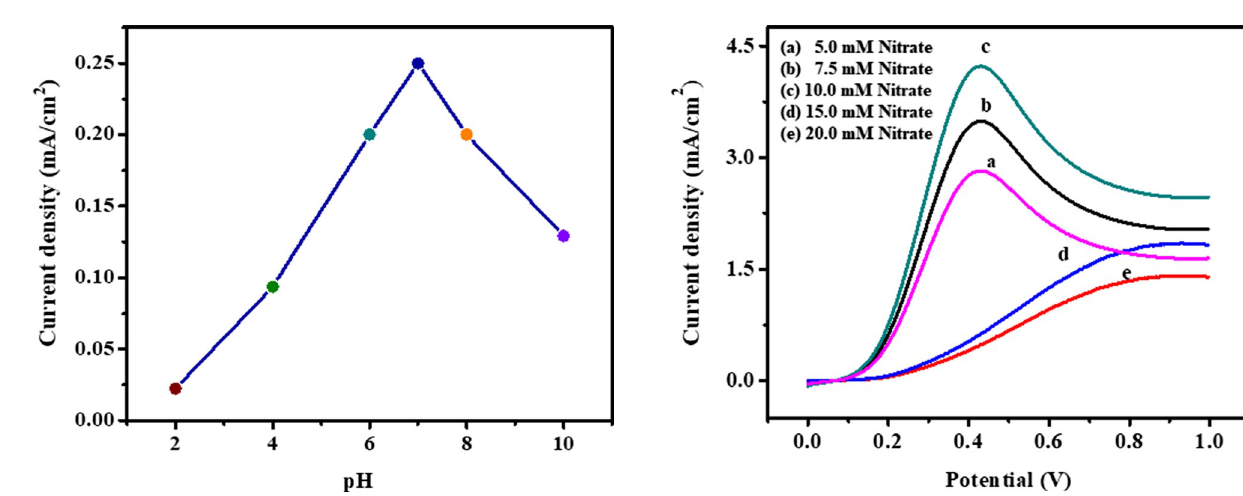
Fig. 8 The effect of pH on the catalytic response of the biosensor (scan rate = 100 mV s −1 )